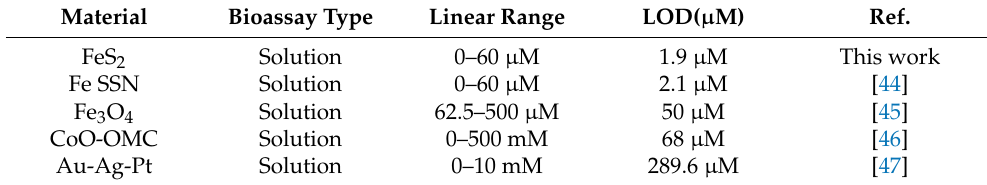
Figure 4. ( A ) UV–vis absorption spectra of FeS 2 /CS@Gox in different glucose concentrations. ( B ) Linear calibration curve of the absorbance at 652 nm against glucose concentration. ( C ) Standard color chart of glucose concentration and color change of FeS 2 /CS@Gox. ( D ) Selectivity toward glucose of the above system against potential interfering substances. ( E ) Shelf life of the glucose detection system. Table 1. Comparison of the colorimetric glucose sensors using various artificial